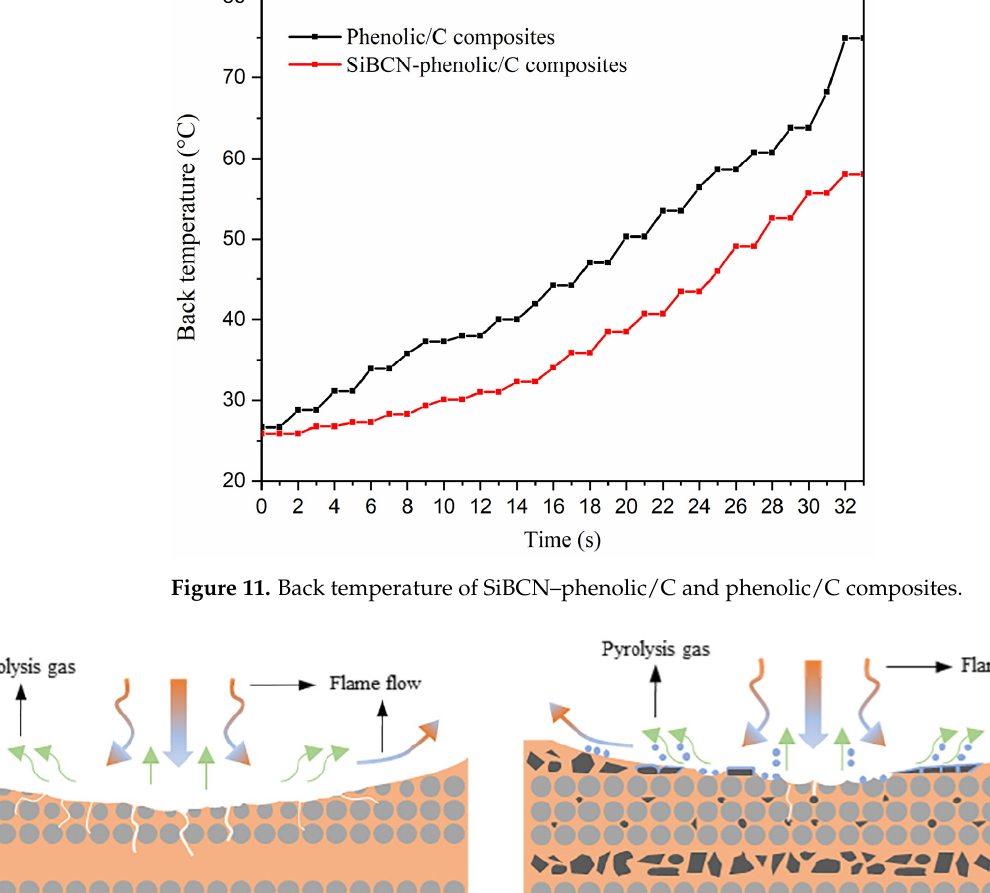
Figure 11. Back temperature of SiBCN–phenolic/C and phenolic/C composites.